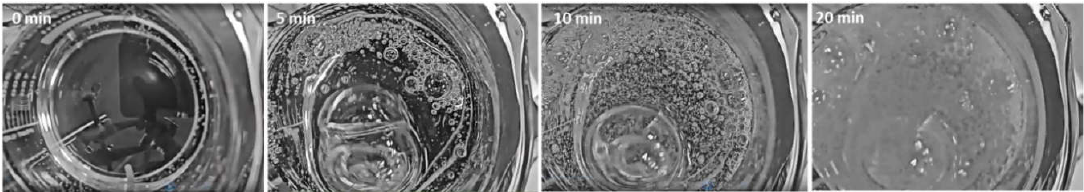
Figure 7. Top view pictures of bubbles reaching the free-surface of the liquid at different times of the crystallization process. The bubbles burst and generate small daughters.